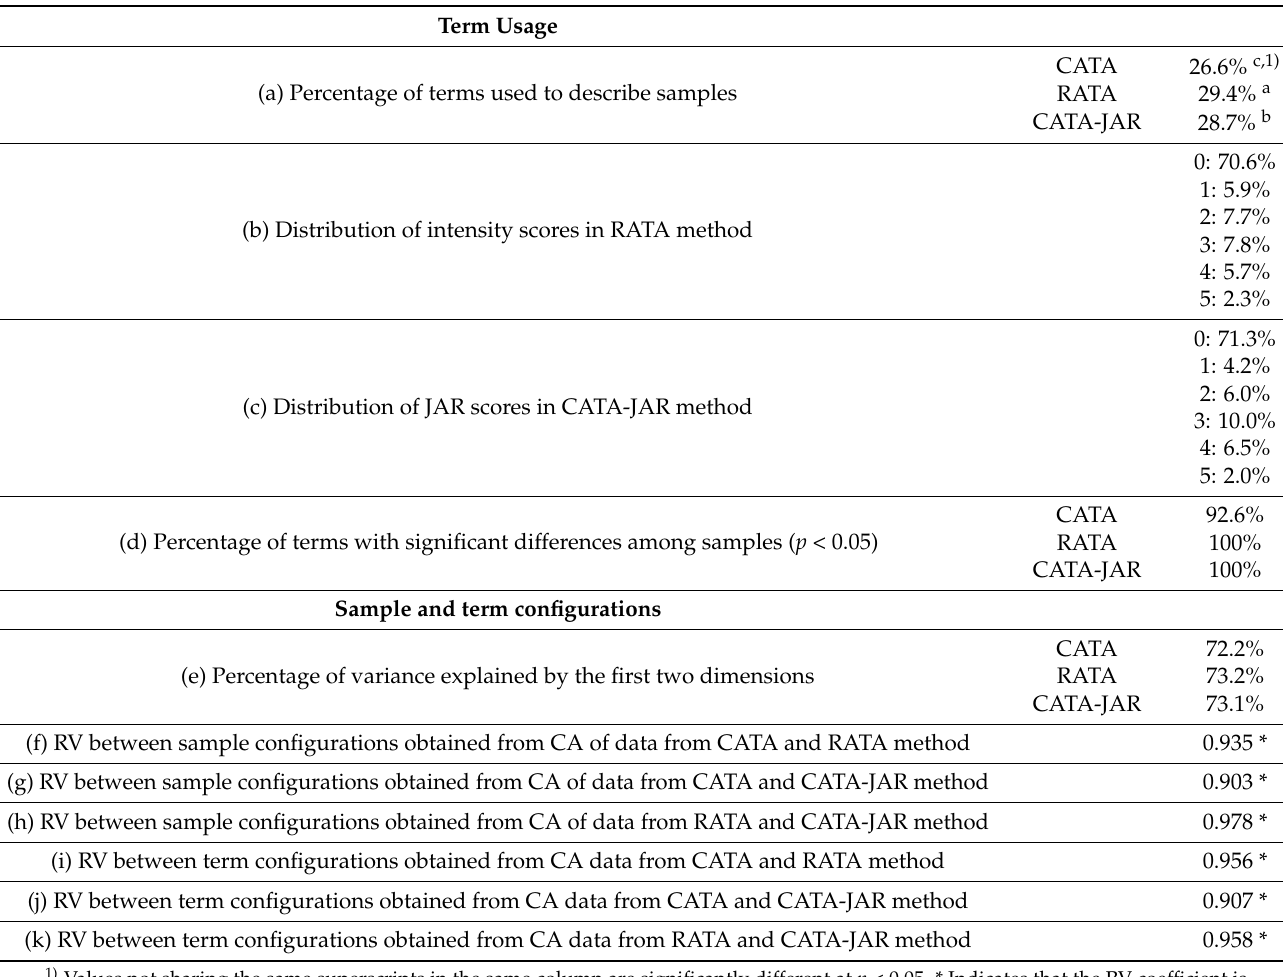
Table 3. Summary of results for the comparison of sensory characterizations with consumers obtained with differ- ent